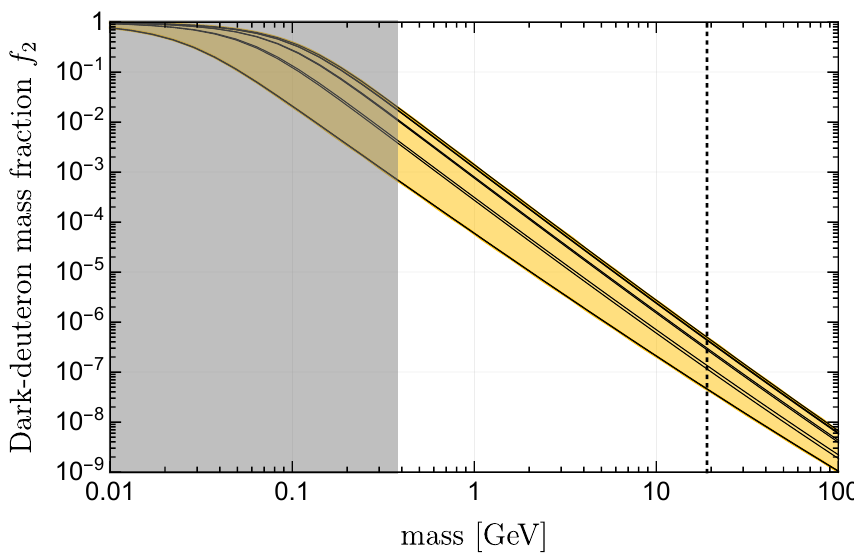
Figure 7 . Dark-deuteron mass fraction f 2 ( z = 0) at late times as a function of the dark matter mass m (cid:31) with the scattering length a determined by (cid:27) elastic =m (cid:31) = 2 cm 2 = g. The curves are for 8 values of the 3-body parameter: a + =a = (cid:21) n= 8 with n = 0 ; 1 ; (cid:1) (cid:1) (cid:1) ; 7. The vertical dotted line marks 0 the mass m (cid:31) = 19 GeV used in (cid:12)gure 6. The results are reliable only well outside the shaded